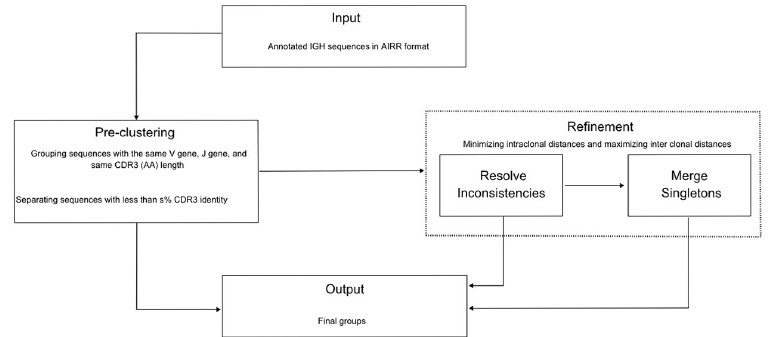
Fig 1. Flowchart of MobiLLe. MobiLLe requires IGH annotated sequences (IGHV, IGHJ, and CDR3 region were previously identified) to form initial clusters (pre-clustering panel), we first group sequences with the same IGHV, IGHJ, and same CDR3 (AA) length; then, we separate sequences with less than s% CDR3 identity (default 70%). Refinement has two steps: ‘resolve inconsistencies’ and ‘merge singletons.’ The first one detects and resolves inconsistencies until no improvement is observed in cluster cohesion or separation. The second one tries to merge singletons into higher-density clusters to improve their uniformity. Final groups (output) represent clonal lineages with low intra-clonal diversity, high inter-clonal diversity, and a minimum number of